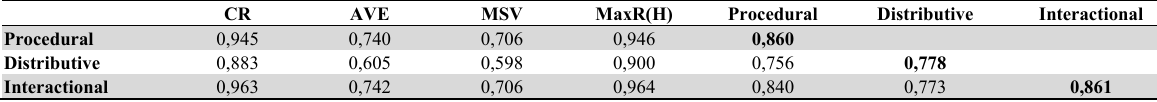
Construct Validity Results of Organizational Justice Scale